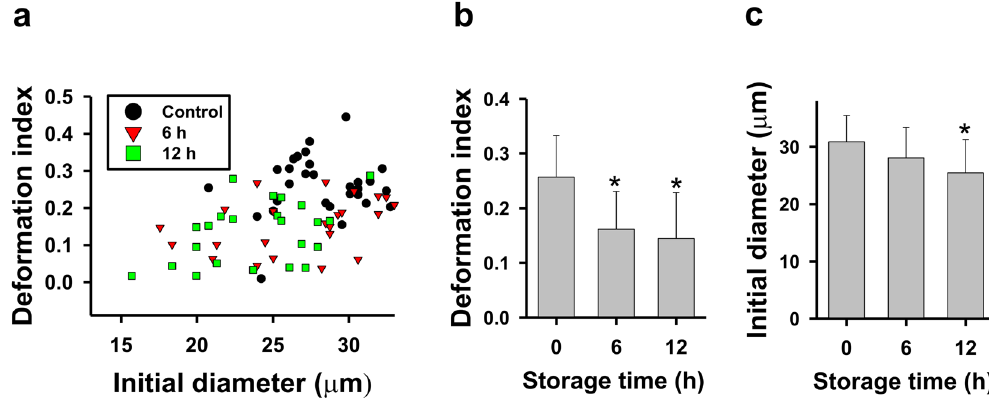
Figure 1. Changes in deformability and cell size of hBM-MSCs stored in PBS. ( a , b ) Cell deformability and ( a , c ) cell size were measured using a four-walled polydimethoxysilane microfluidic device at a flow rate of 160 μ l/h. Data represent mean ± SD (N > 20). * P < 0.05 vs . 0 h